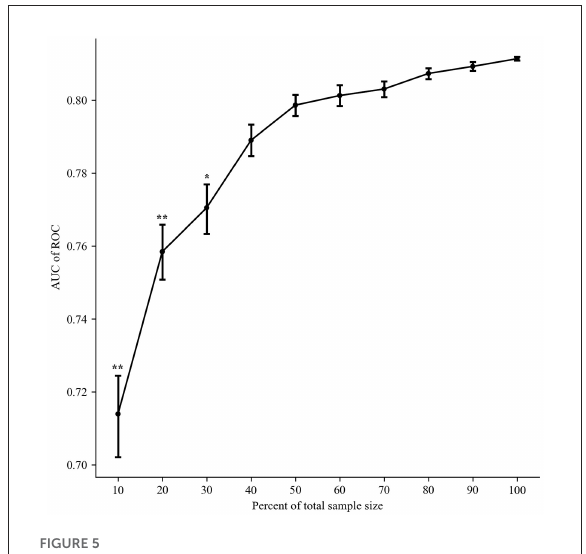
FIGURE5 The impact of sample data size on model performances (mean ±